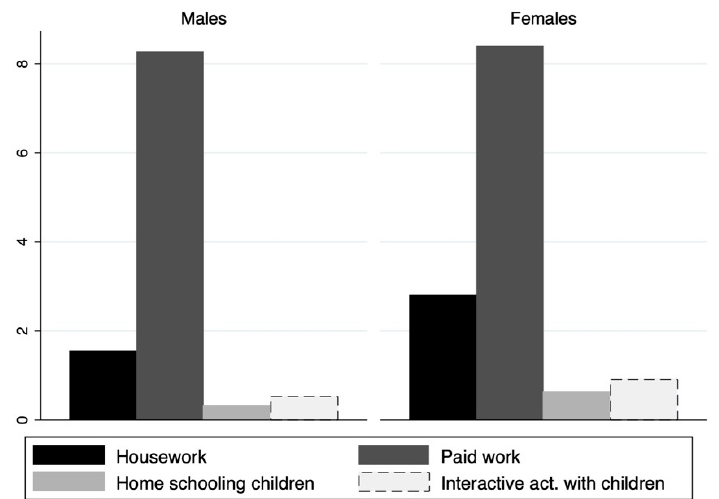
Figure 1. Daily time spent on activities by partnered and employed men and women during the lockdown in the UK (N = 2099).